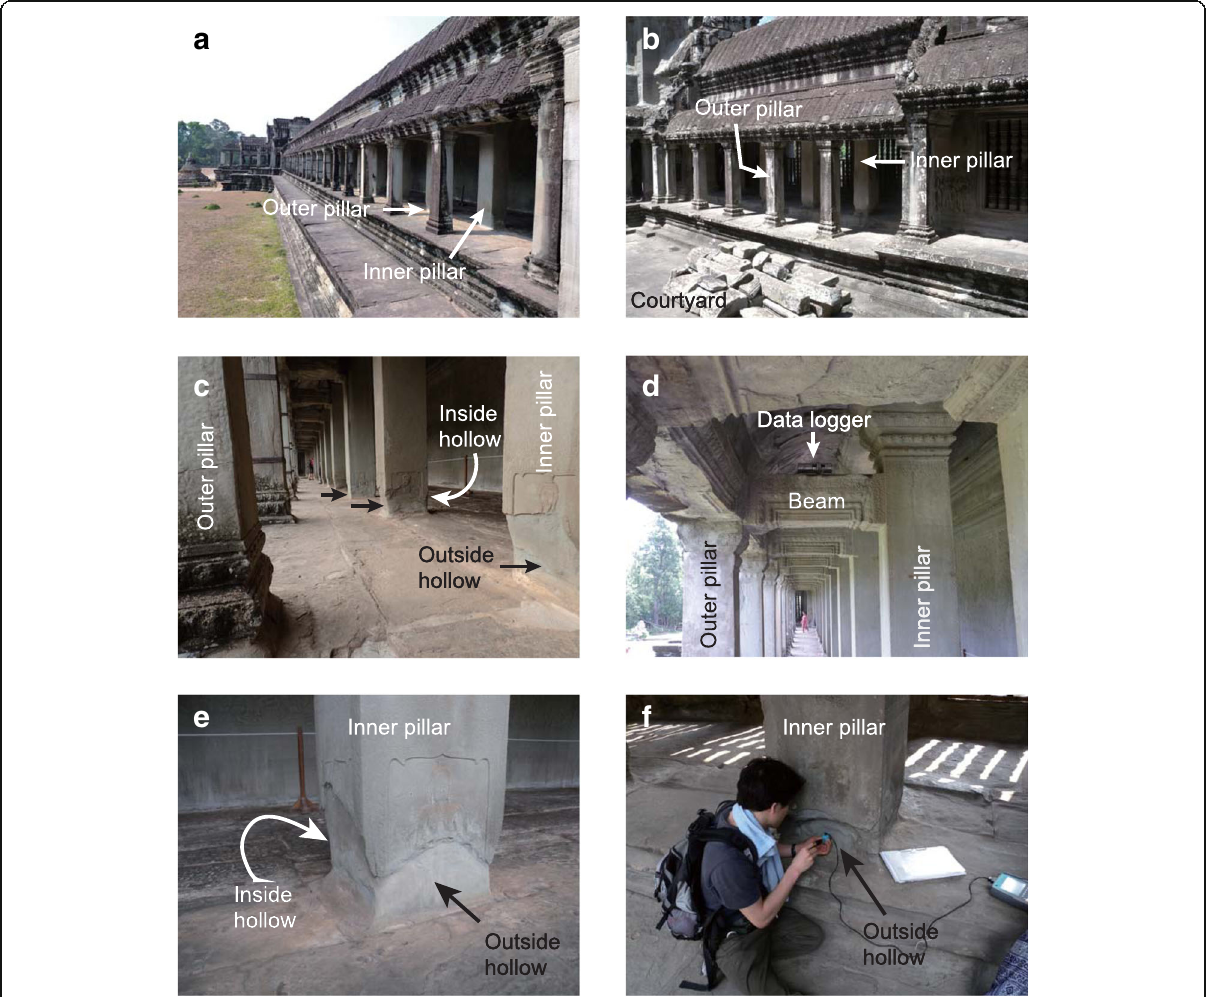
Fig. 3 Galleries and sandstone pillars of Angkor Wat temple. a Eastern side of the first gallery (1E). b Eastern side of the third gallery. c The inner and outer pillars in the first gallery. d A data logger on the beam in the first gallery. e The inner pillar accompanied with the hollow of the first gallery. f The hardness measurement on the inner pillar at the third